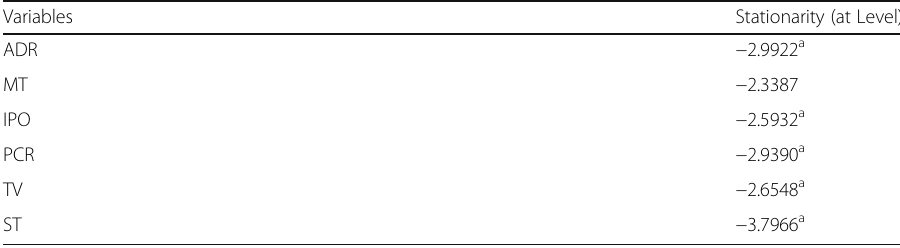
Table 1 Unit root